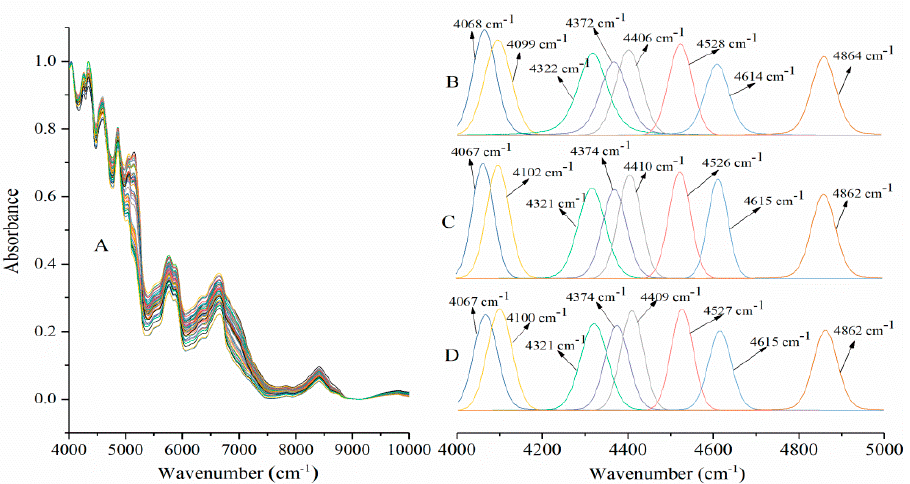
Figure 1. Near-infrared spectra of soybean protein isolate (SPI) after high-intensity ultrasonication Untreated-SPI, C : HIU-600 W-30 min-SPI, D : HIU-1400 W-5 (HIU) treatment from 4000 to 10,000 cm − 1 ( A ) and fitting of peaks to SPI from 4000 to 5000 cm − 1 ( B : Untreated-SPI, C : HIU-600 W-30 min-SPI, D : HIU-1400 W-5 min-SPI).